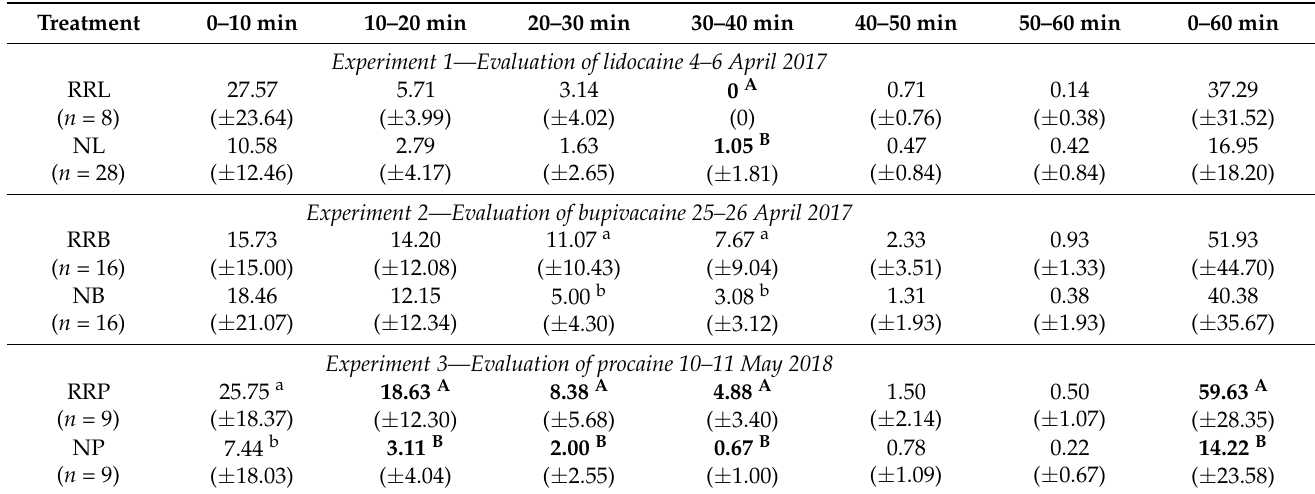
Table 4. Mean ( ± standard deviation) count of total active pain-related behaviors expressed by female lambs. Within each experiment, means within a column with differing uppercase superscripts (A, B) differ significantly ( p < 0.05), while differing lowercase superscripts (a, b) indicate a tendency to differ (0.1 > p > 0.05). RRL ring only, no local anesthetic; NL ring applied with lidocaine administered using the Numnuts ® tool; RRB ring only, no local anesthetic; NB ring applied with bupivacaine administered using the Numnuts ® tool; RRP ring only, no local anesthetic; NP ring applied with procaine administered using the Numnuts ®